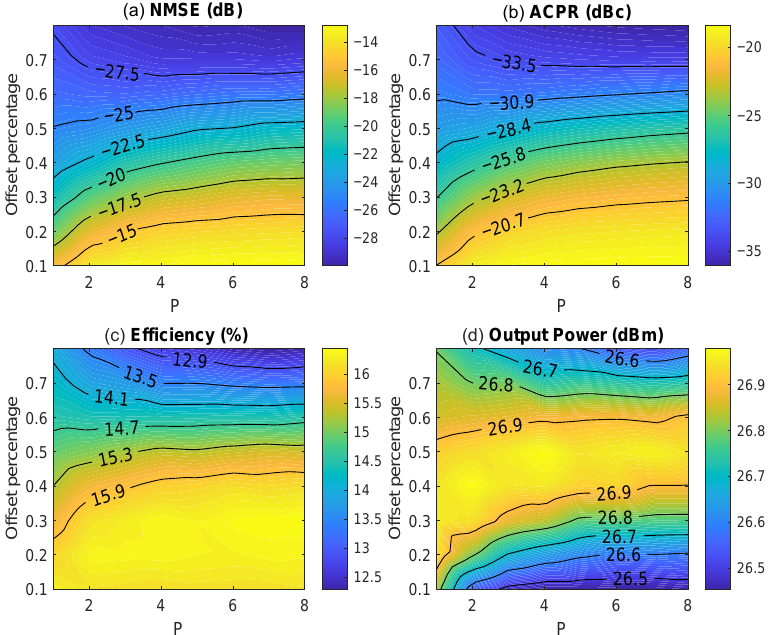
Figure 2. NMSE ( a ), ACPR ( b ), efficiency ( c ), and output power ( d ) performance of the ET PA with the NR-60 MHz OFDM-like signal, using the detroughing envelope with different offset percentage and p